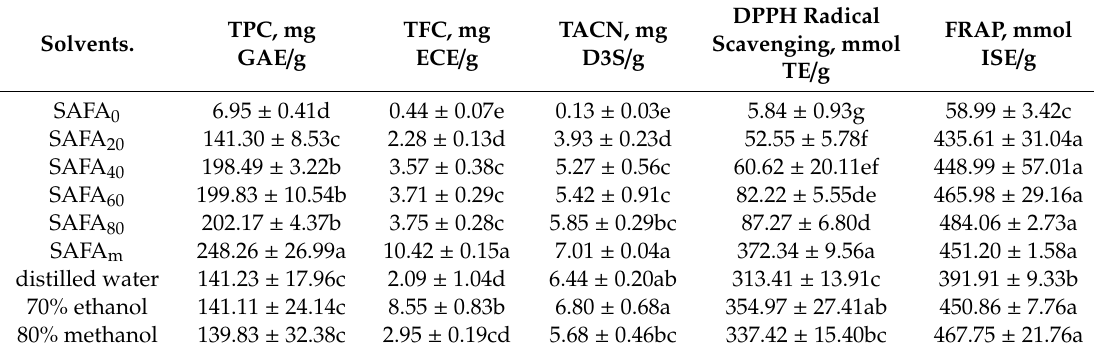
Table 2. TPC, TFC, TACN and antioxidant activity (DPPH radical scavenging and FRAP) of Roselle calyces using DES and conventional